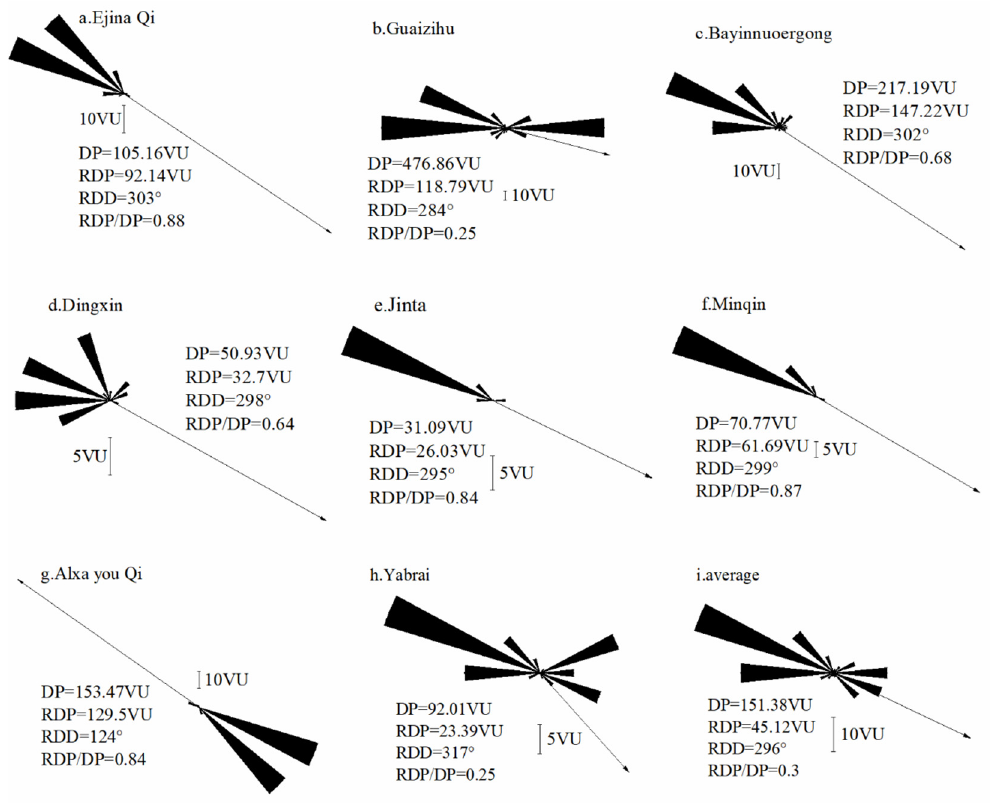
Figure 8. Wind regime of ( a ) Ejina Qi, ( b ) Guaizihu, ( c ) Bayinnuoergong, ( d ) Dingxin, ( e ) Jinta, ( f ) Minqin, ( g ) Alxa you Qi, ( h ) Yabrai and ( i ) BJD.